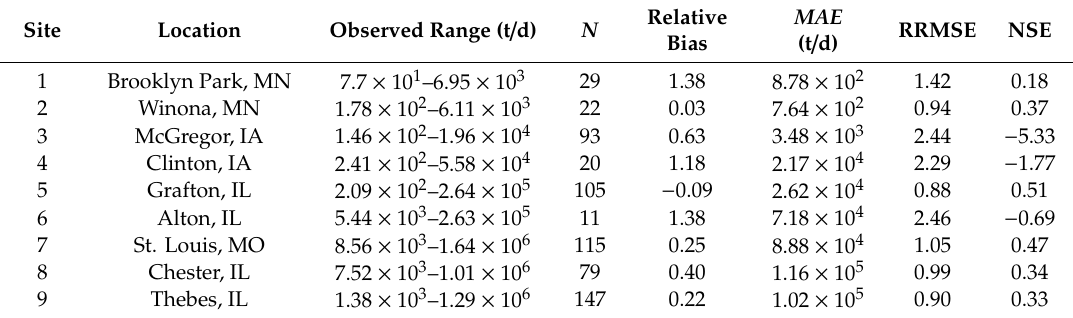
Table 7. Model performance of sediment discharge estimation for the individual study sites.